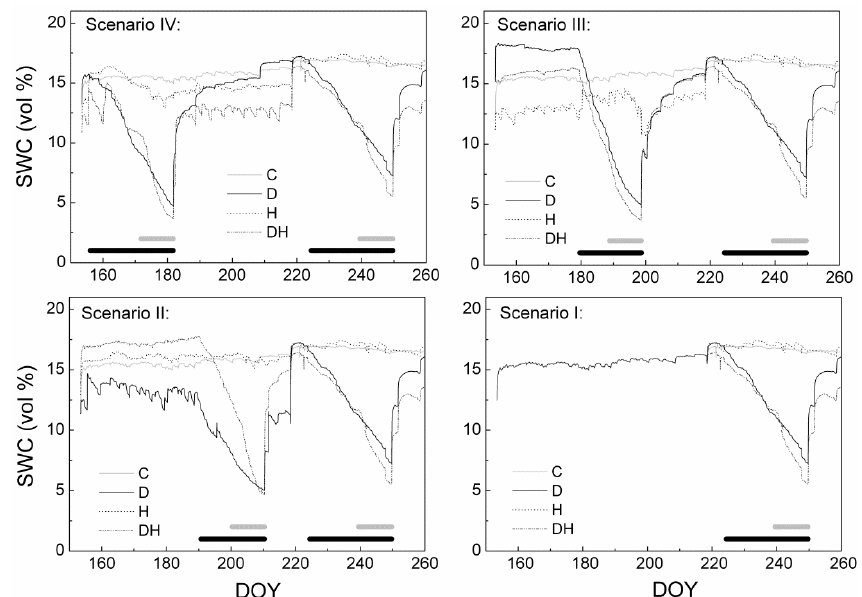
Fig. 1. Volumetric soil water content (SWC) during different scenarios and treatments. C = control, D = drought, H = heat, DH = drought + heat. Bottom lines in each graph indicate timing of the climate events (black line = timing of drought extreme, grey line = timing of heat extreme). Scenario IV = 42-day interval between subsequent events, scenario III = 25-day interval, scenario II = 14-day interval, scenario I = single event.